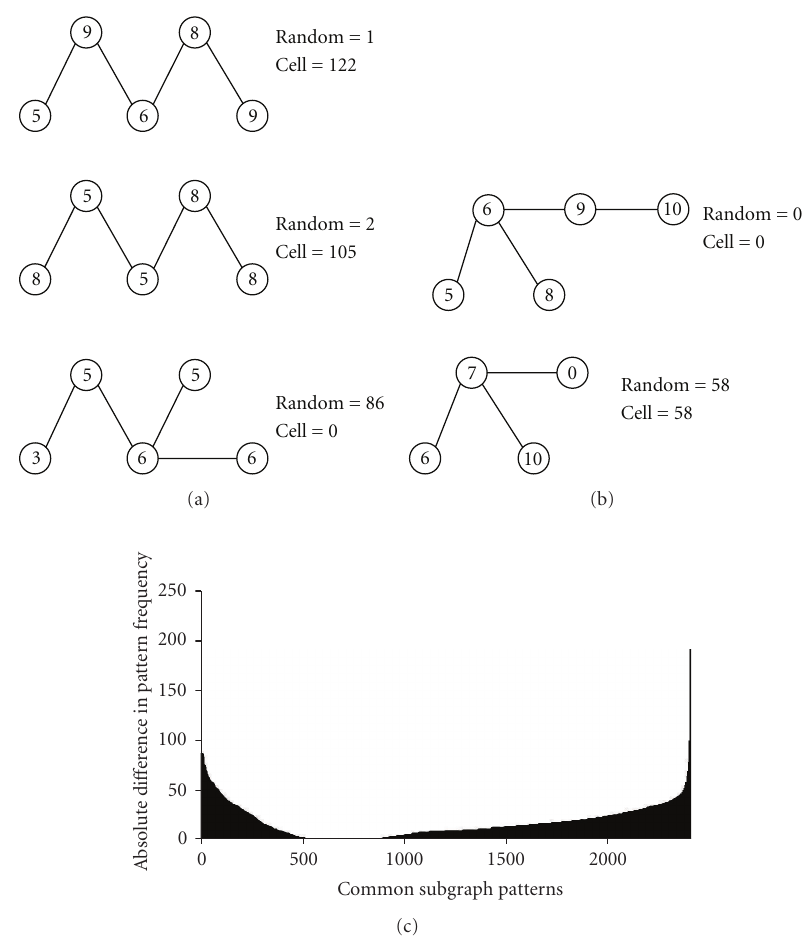
Figure 10: Common cell subgraph patterns are distinct from patterns extracted from random graphs. Subgraph patterns were identified that represented local graph topologies and compared to their frequency in random graphs. (a) Significant cell-graph patterns not found in random graphs. (b) Patterns found equally in random and cell-graphs and are therefore not significant. (c) Histogram of all patterns common among cell-graphs plotted as the absolute di ff erence between frequencies in random versus cell-graphs. Patterns at the extremes indicate significant